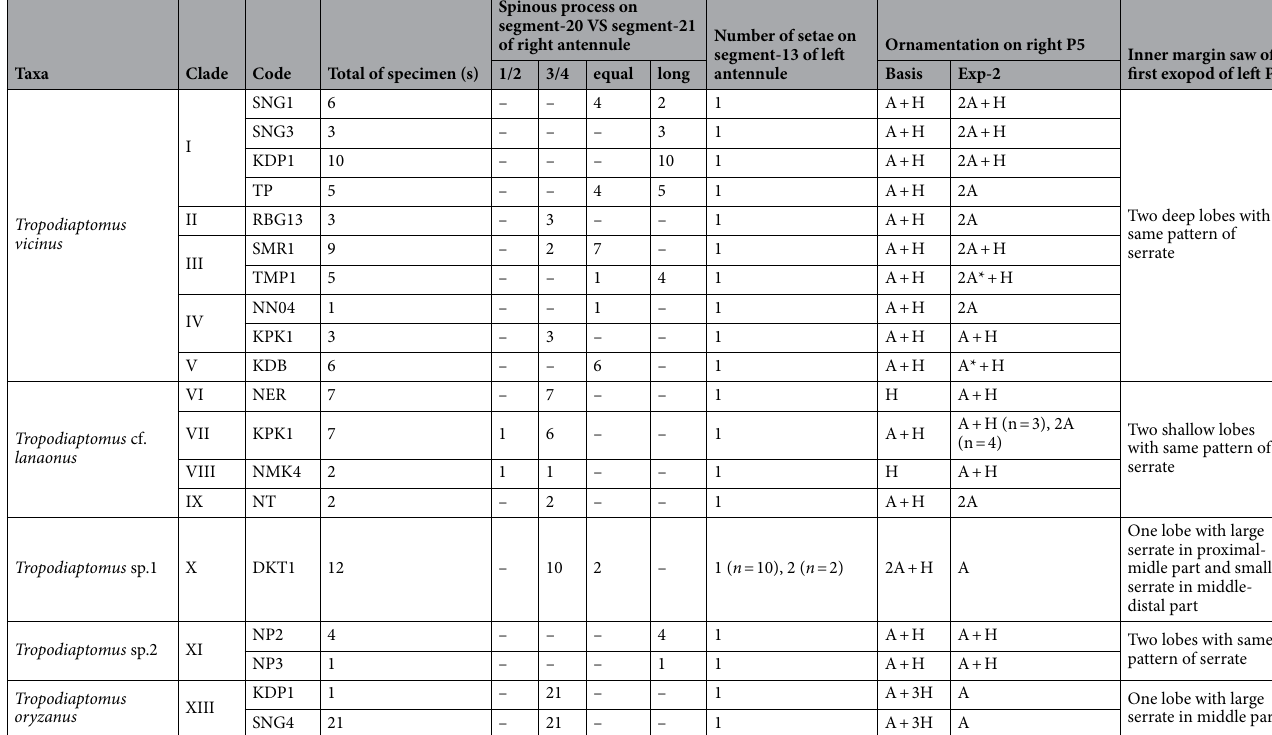
Table 2. Morphology of adult males in studied Thai Tropodiaptomus taxa and populations. A apophysis, H hyaline lamella *Distal margin of exp-2 of right fifth leg with long apophysis).